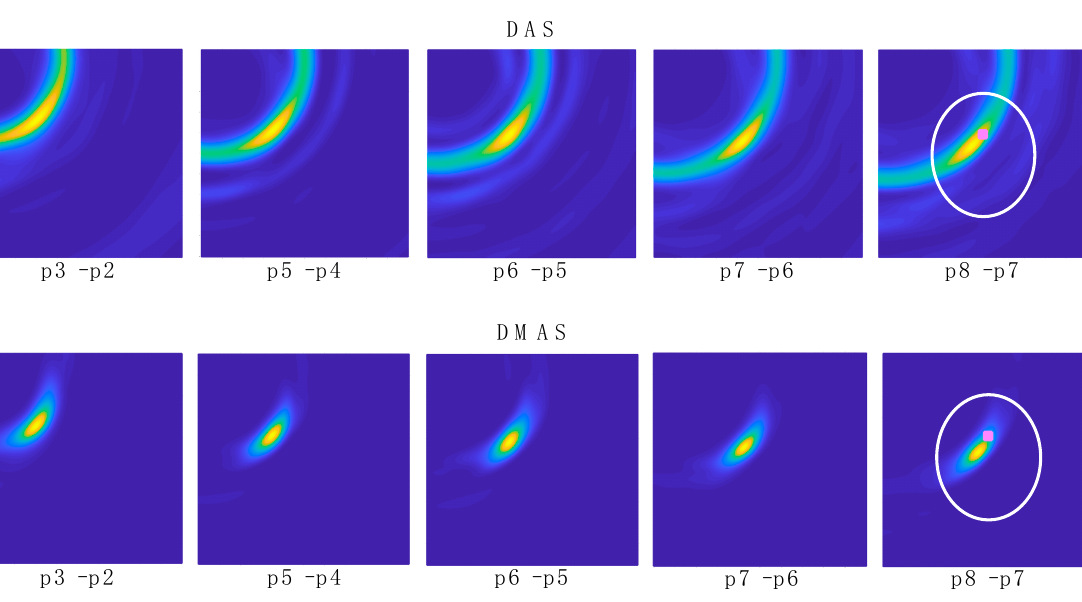
Figure 13. Navigation images for a selection of the positions obtained with DAS and DMAS algo- rithms. The position and shape of the cranium (white) and tumor (pink)are depicted in the last image for reference.